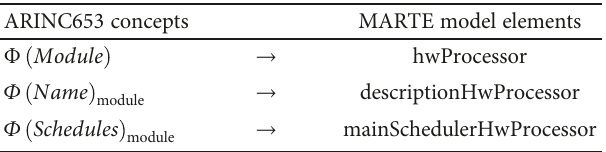
Figure 2: The basic modeling elements and structure of Table 2: Module transformation rules.